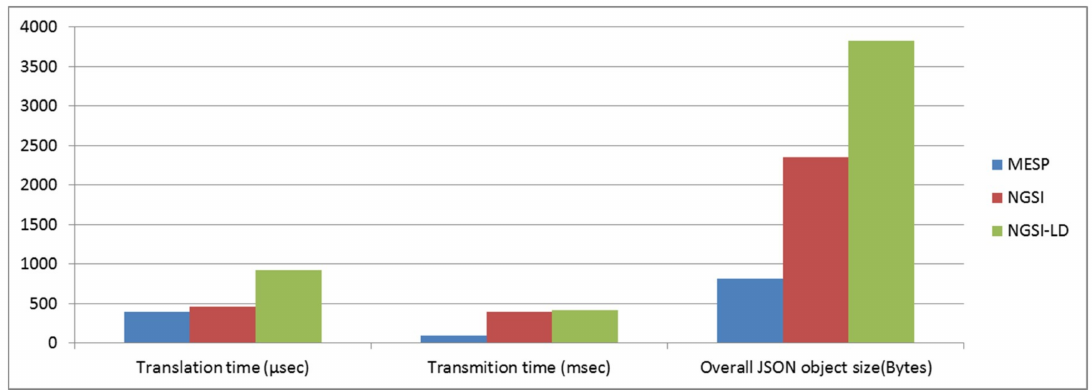
Figure 14. Average data translation time, average data transmission time and overall JSON object size for the original MESP, NGSI and NGSI-LD